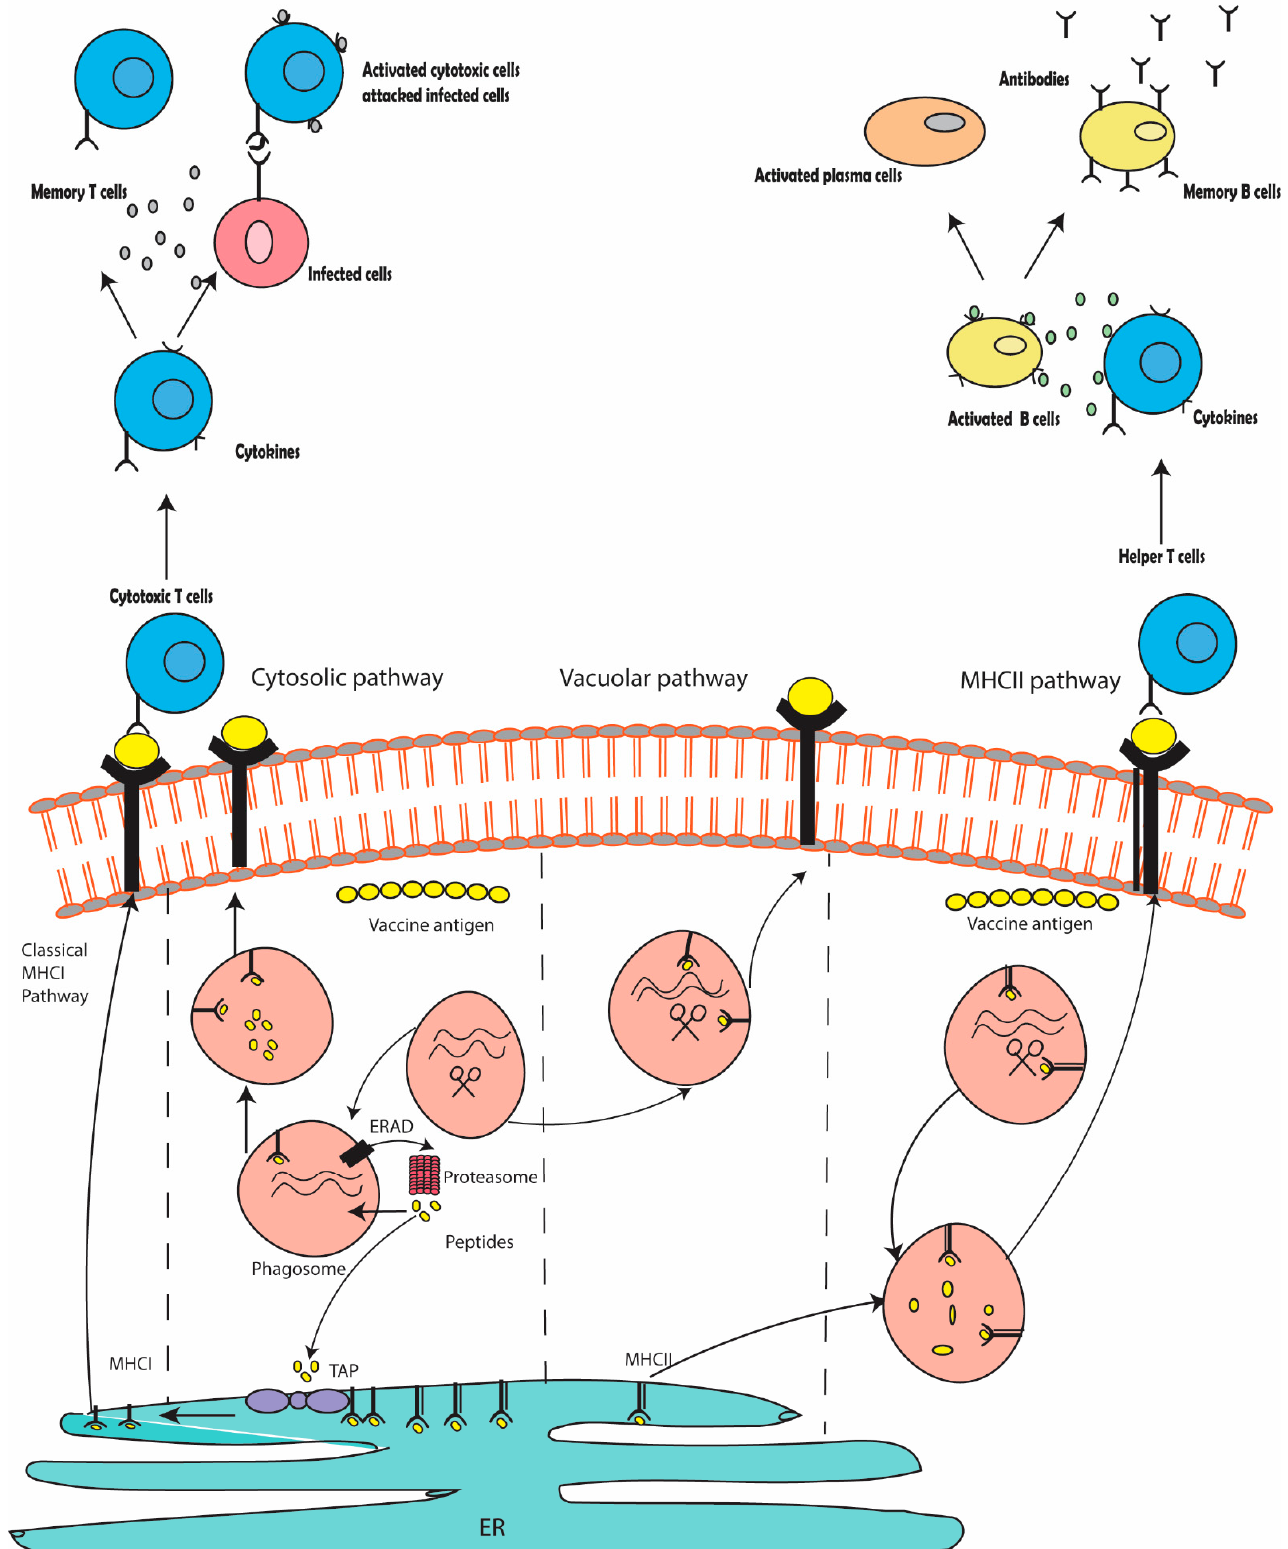
Figure 1. The molecular mechanism of immune responses stimulated by epitope-based vaccine can- didate.